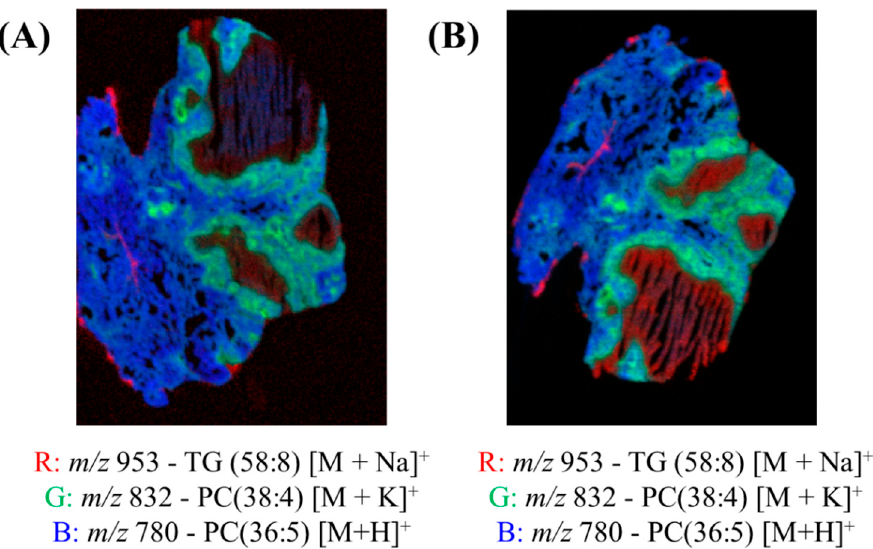
Figure 4. Red, green and blue (RGB) overlay of m / z 953 (TG (58:8) [M+Na] + ), m / z 832 (PC (38:4) [M+K] + ) and m / z 780 (PC(36:5) [M+H] + ) obtained using DESI and two spray solvents—( A ) 95:5 (% v/v ) MeOH:H 2 O and ( B ) 50:50 (% v/v ) MeOH:EtOH.